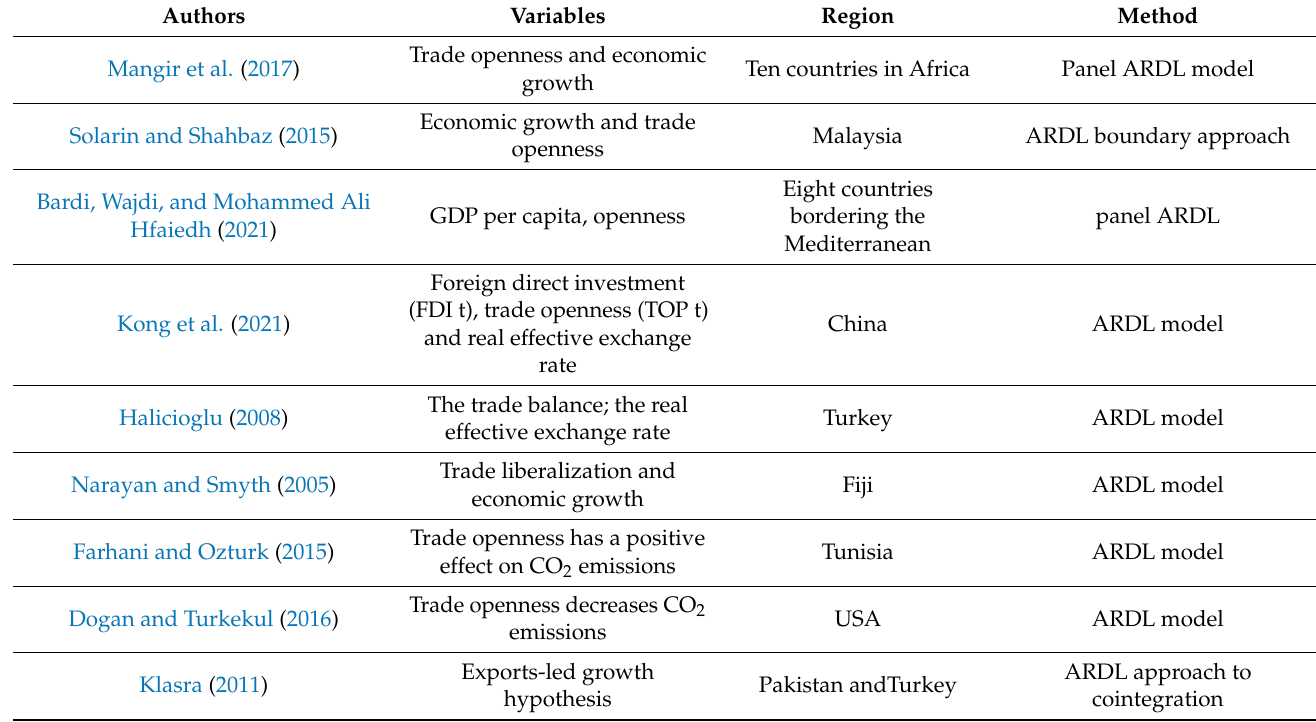
Table 1. Some models used in international trade